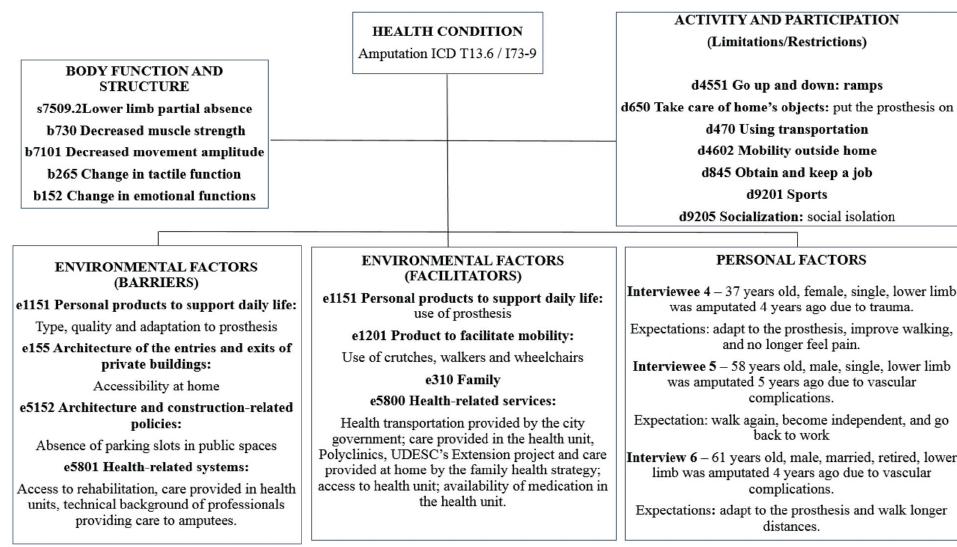
Figure 2 - ICF Conceptual Interaction Model – Amputees who use